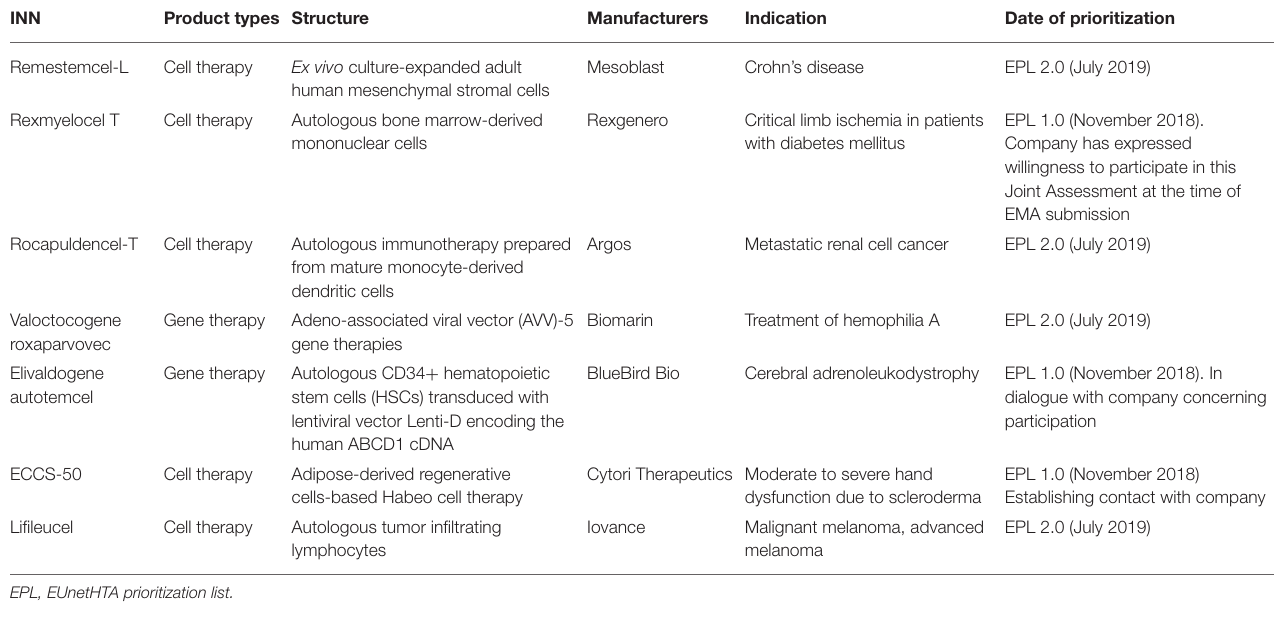
TABLE 5 | ATMPs that are included on EUnetHTA prioritization list.